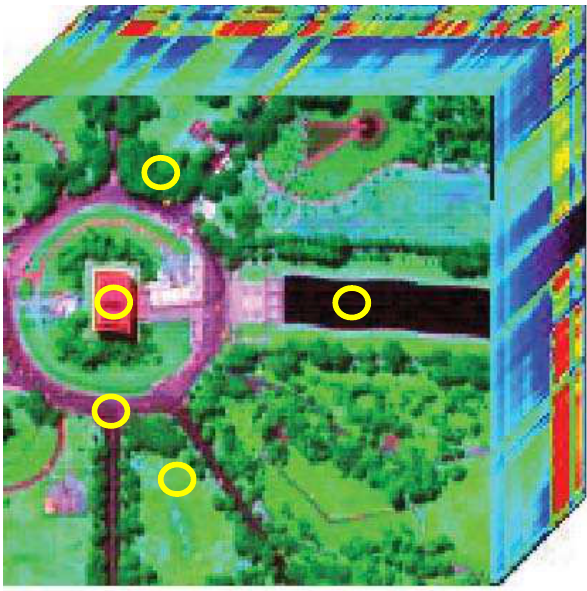
Figure 7. The 3D cube of Washington DC Mall data. This data is selected from the original hyper- spectral image and has 150 × 150 pixels. There are five types of endmembers in the scene including Tree, Grass, Street, Roof, and